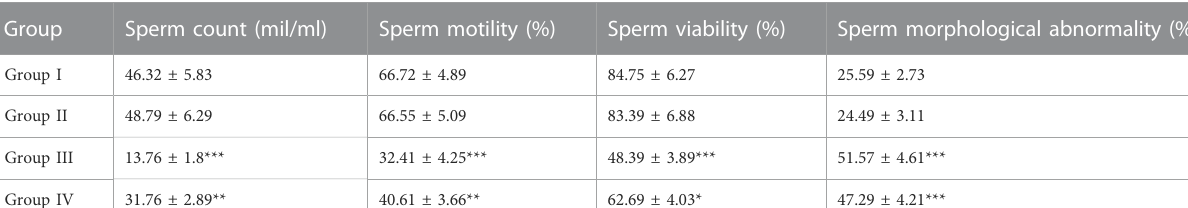
TABLE 1 Cauda epididymal sperm characteristics in animals with and without pre-treatment with C. borivilianum root extract (CRE). The asterisks are levels of signi fi cance against Group I, where * p < 0.05, ** p < 0.01, and *** p < 0.001. Group